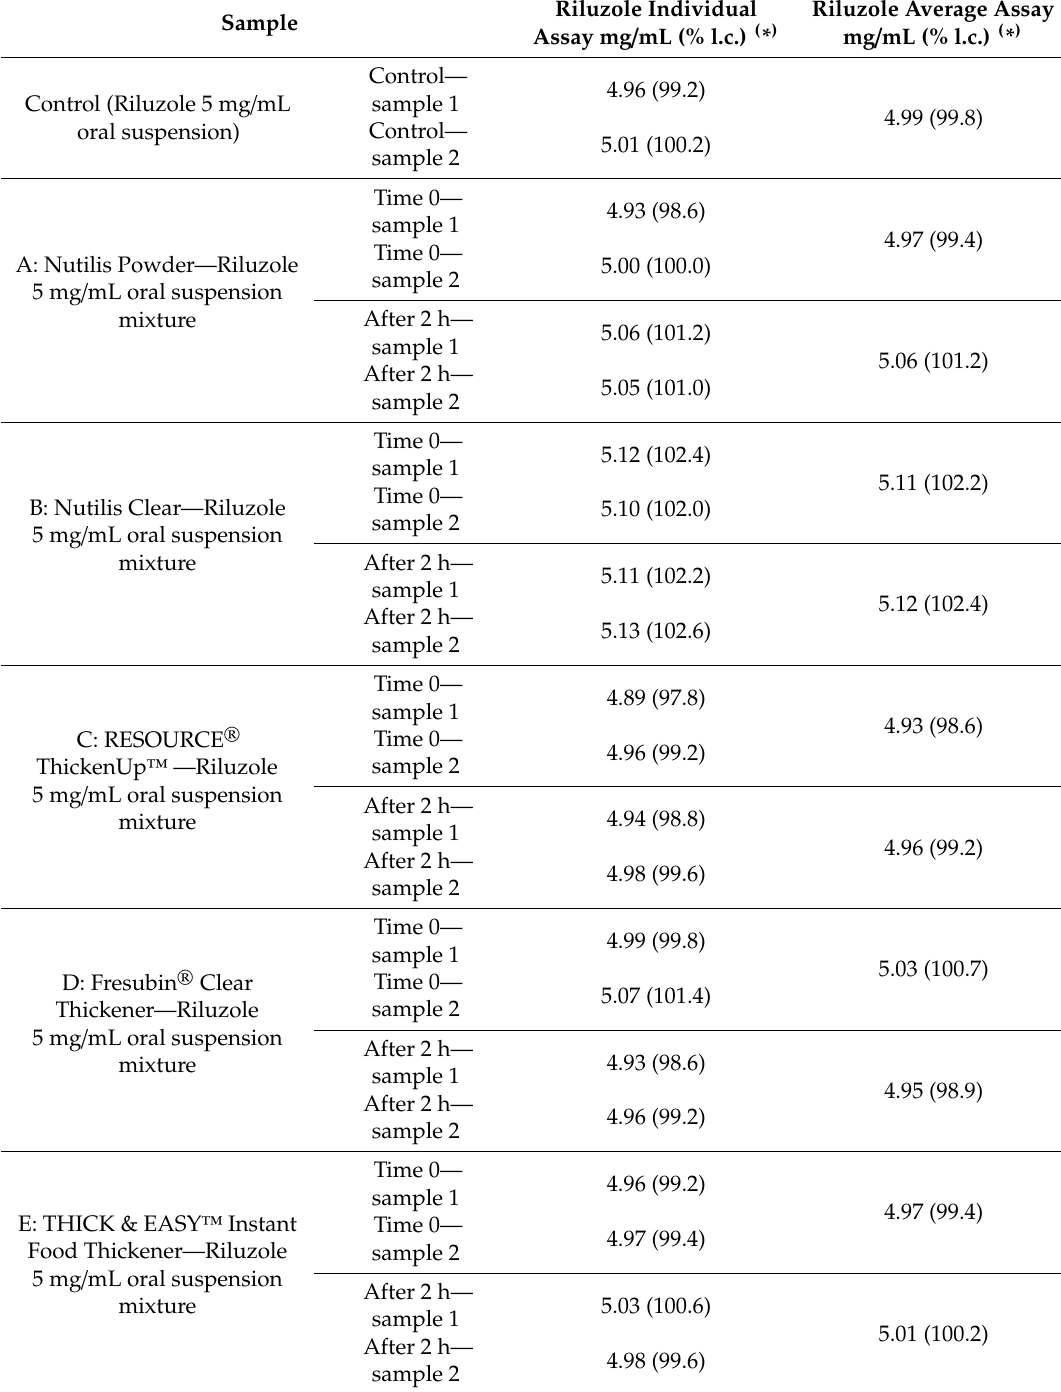
Table 5. Riluzole HPLC Assay